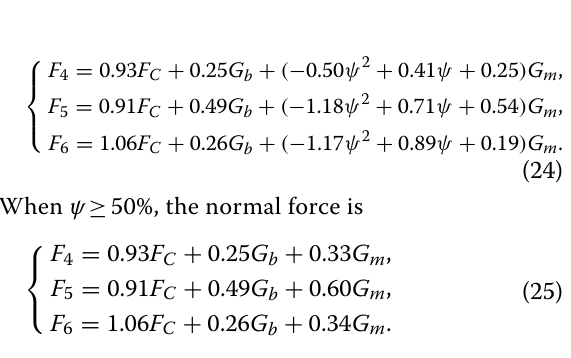
Table 3 Value of F